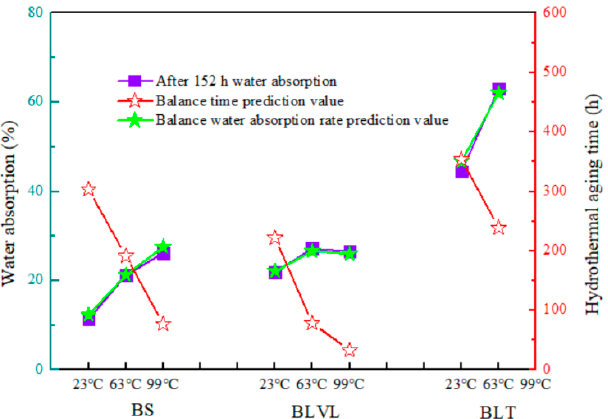
Figure 4. A comparison of the predicted and measured values of the three types of bamboo